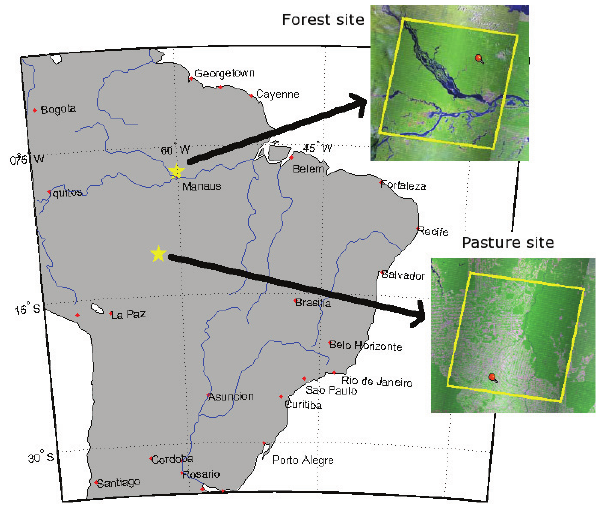
Fig. 1. Diagram showing the locations of the two Amazonian sam- pling sites considered in this study. Satellite data available from the US Geological